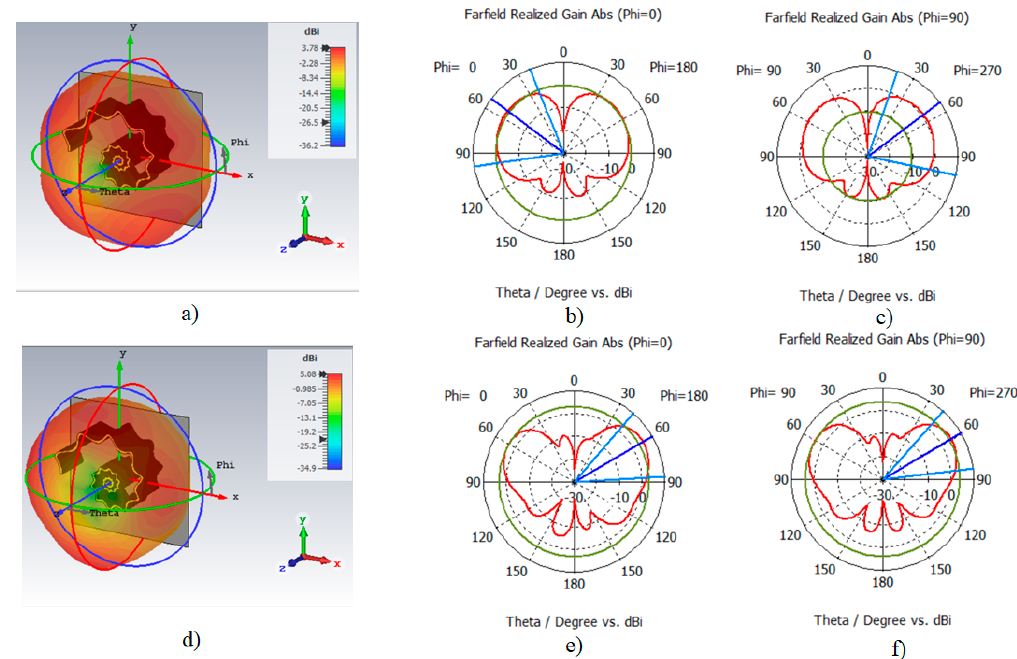
Figure 7. ( a ) 3D radiation pattern of the optimized SsDRA at 3.5 GHz; ( b ) E-plane of the optimized SsDRA at 3.5 GHz; ( c ) H-plane radiation patterns of the optimized SsDRA at 3.5 GHz; ( d ) 3D radiation pattern of the optimized SsDRA at 5.5 GHz; ( e ) E-plane of the optimized SsDRA at 5.5 GHz; ( f ) H-plane of the optimized SsDRA at 5.5 GHz. Appl. Sci. 2020 , 10 , x FOR PEER REVIEW